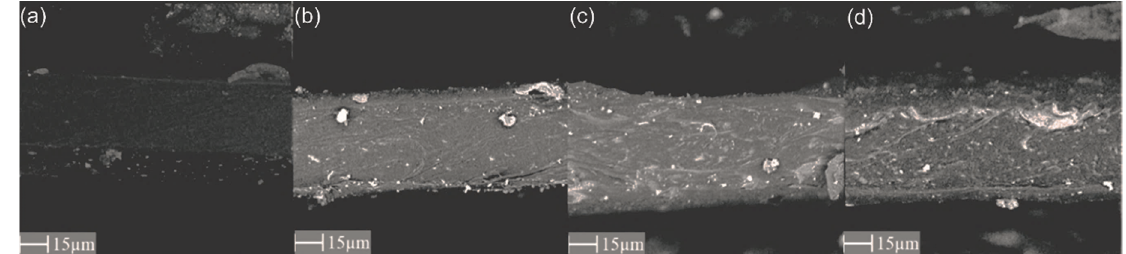
Figure 4. SEM image of membrane cross section with ZIF-8 added; ( a ) PEBAX 2533 + 0 wt% ZIF-8, ( b ) PEBAX 2533 + 2 wt% ZIF-8, ( c ) PEBAX 2533 + 5 wt% ZIF-8, ( d ) PEBAX 2533 + 10 wt% ZIF-8.